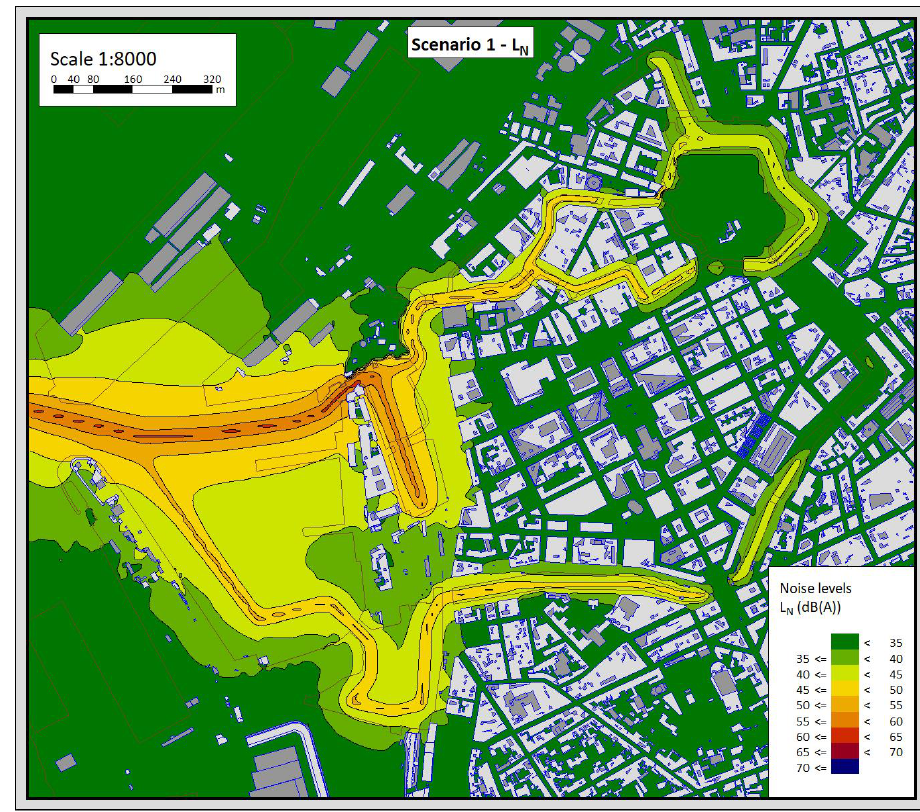
Figure 6. L N noise contours map for Scenario 1 (present).